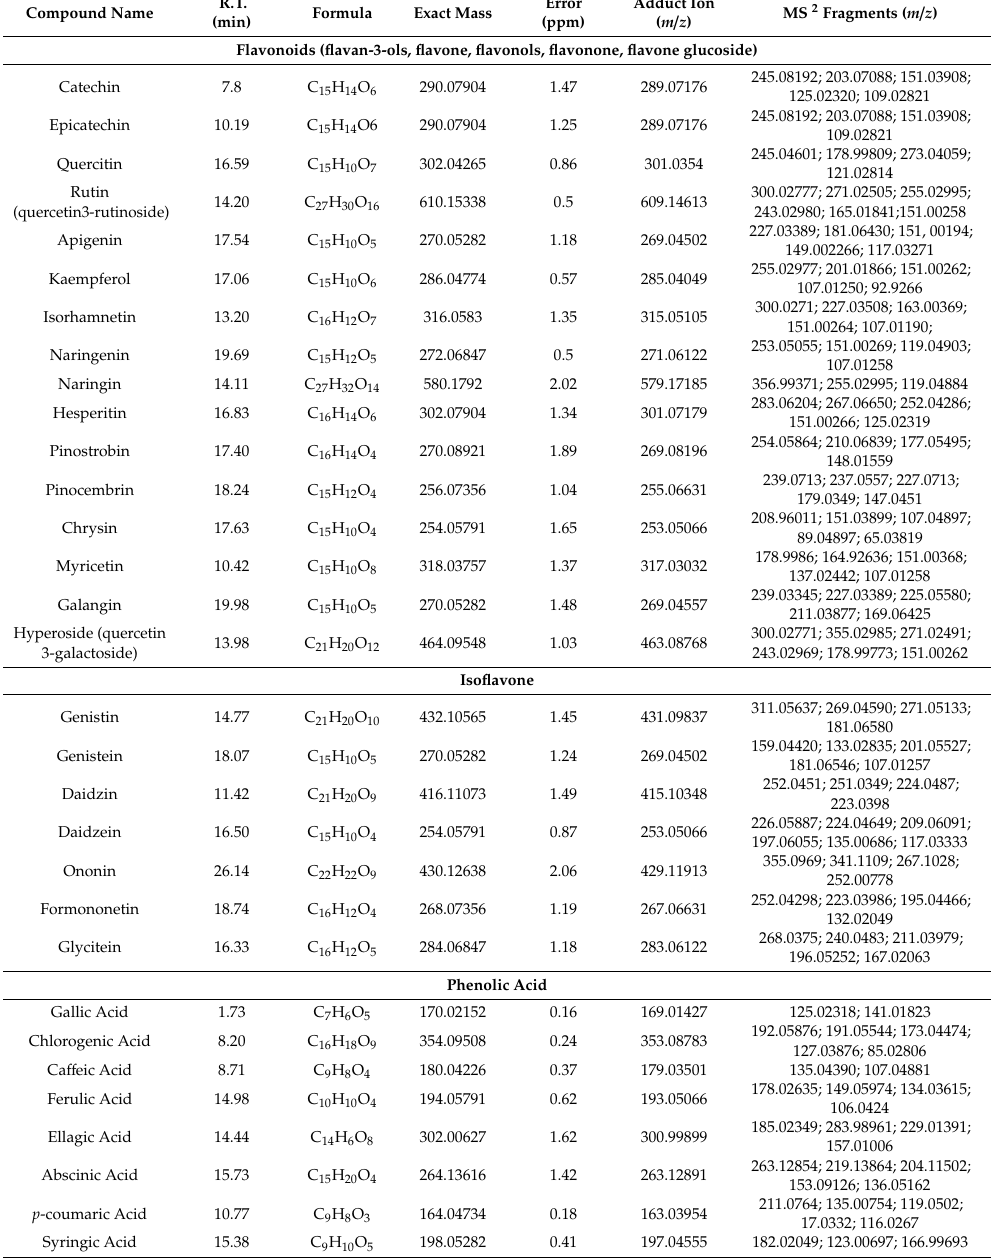
Table 1. The 30 compounds identified from alfalfa and red clover sprouts by UHPLC-Q-Exactive with structures confirmed by comparison with reference